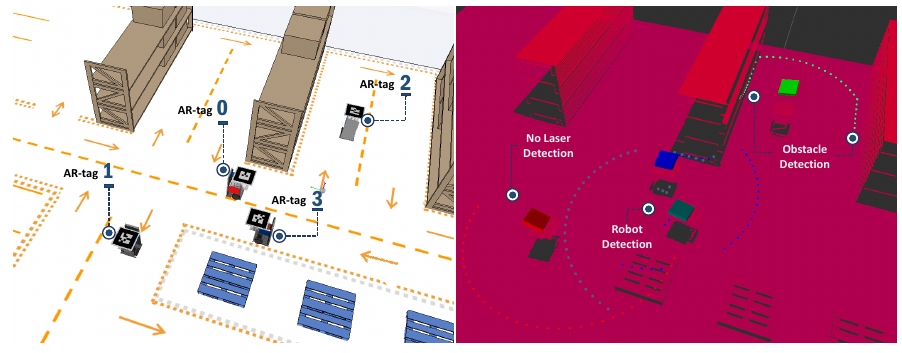
Figure 10. Example of virtual LRFs in the ARENA.